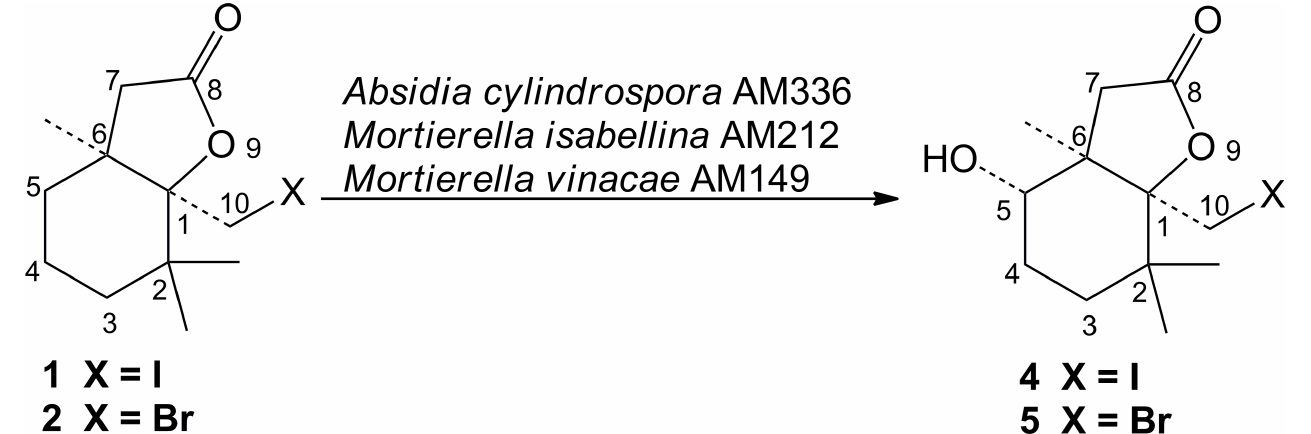
Fig 1. Biohydroxylation of iodo- and bromolactones (1 and 2).